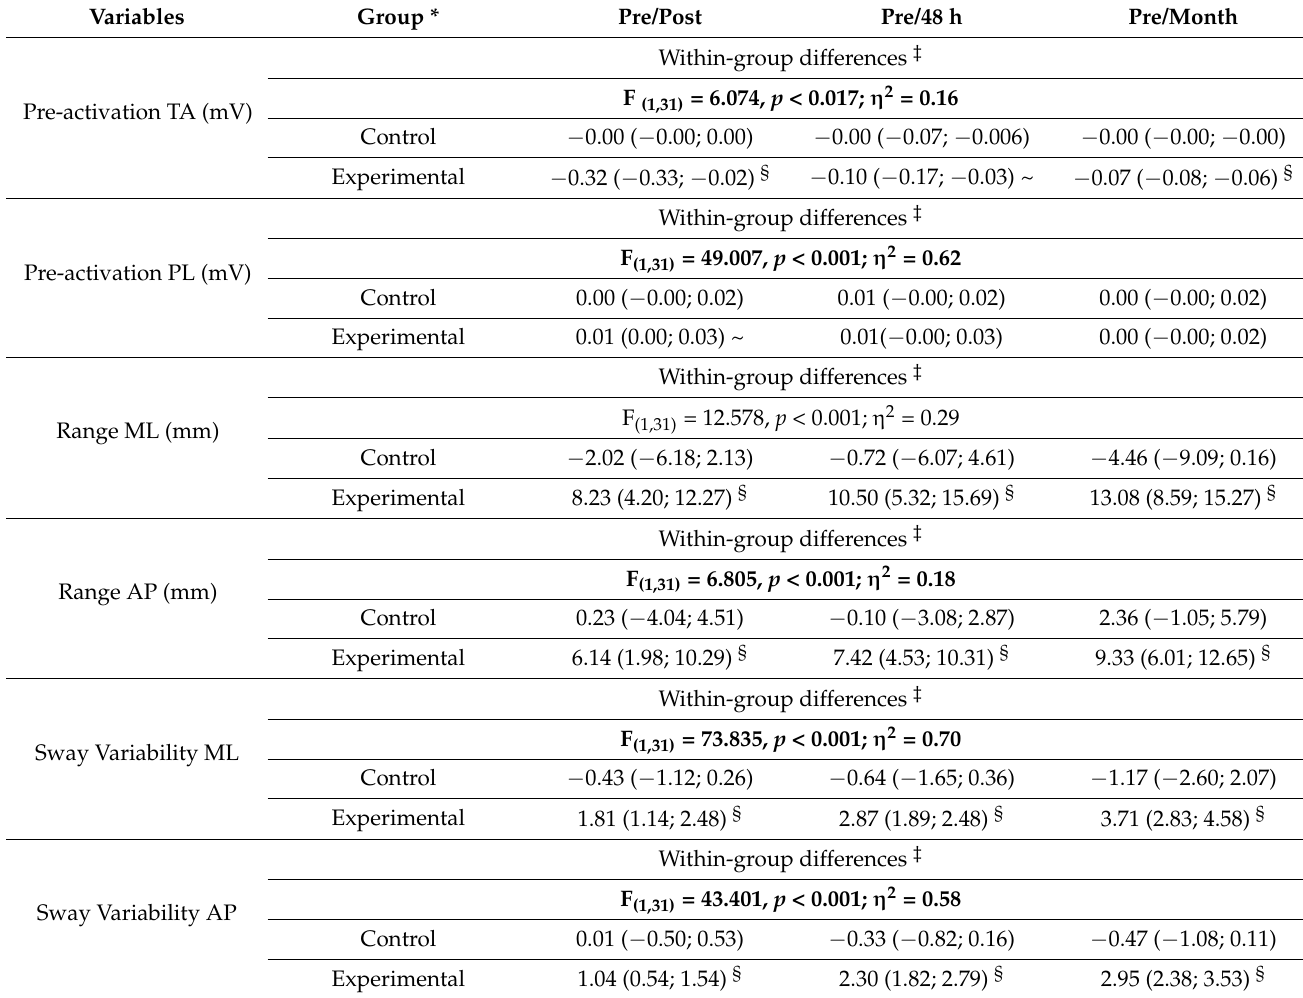
Table 5. Within-group